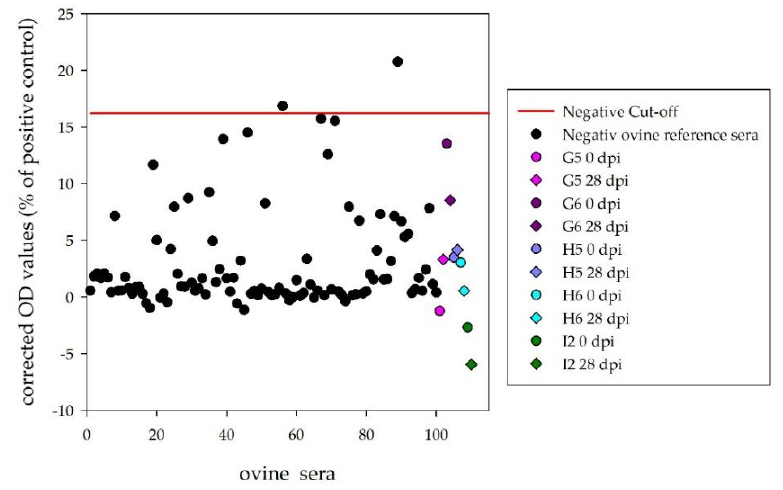
Figure 3. Ovine DUGV ELISA: 100 negative German sheep sera were used to determine the ELISA cut-off. OD values of the four inoculated sheep (G5, G6, H5, H6) and the control animal (I2) were below the determined cut-off prior to and post inoculation (28 dpi).